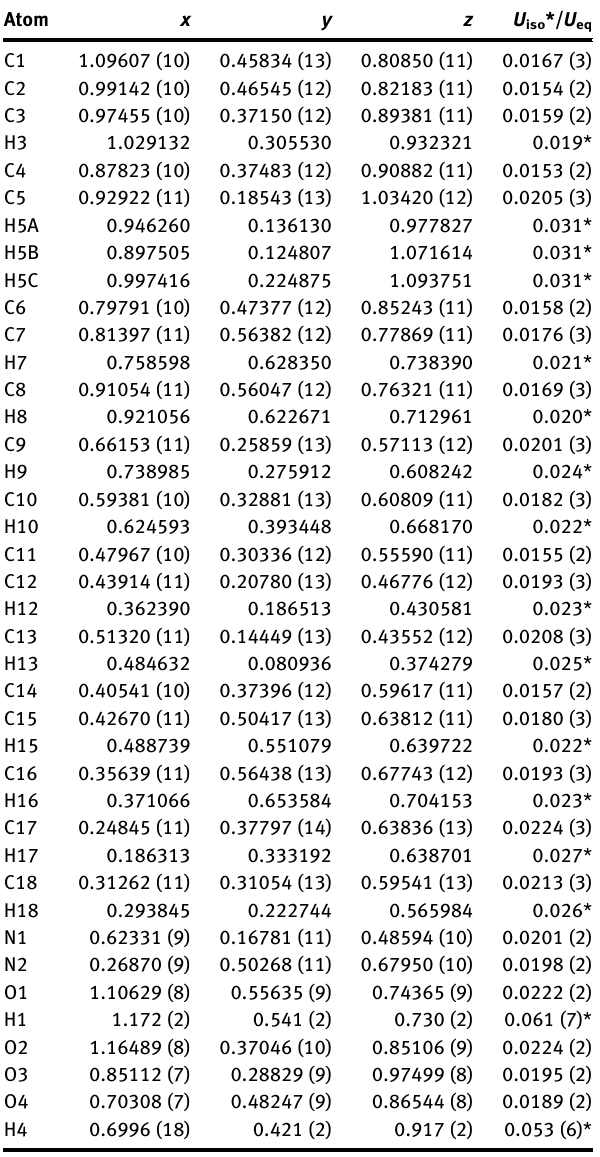
Table  : Fractional atomic coordinates and isotropic or equivalent isotropic displacement parameters (Å  ).